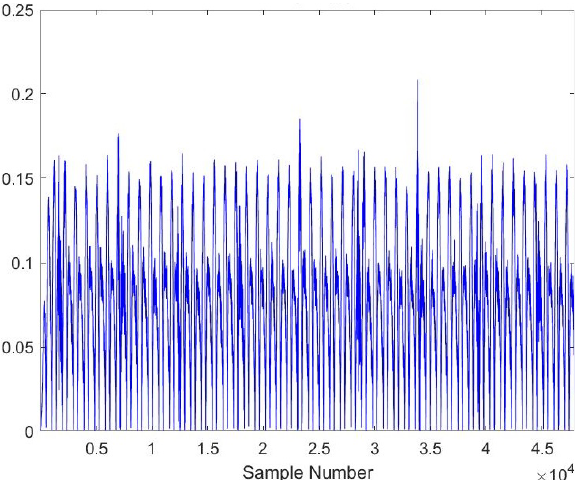
Figure 7. RMS plot of Hardwood, Worn-out Tool, 2 mm depth-of-cut.